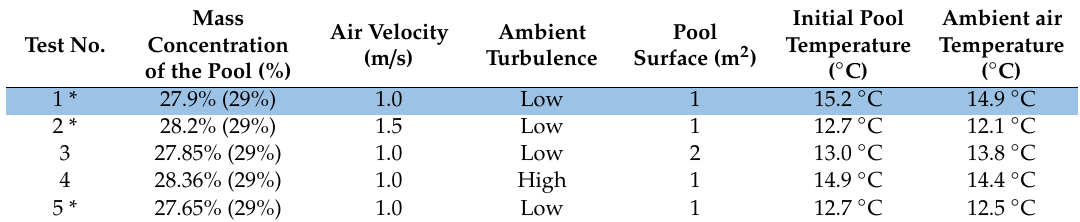
Table 2. Presentation of the medium scale tests. Concentration given by the provider is given in brackets ( ). Test